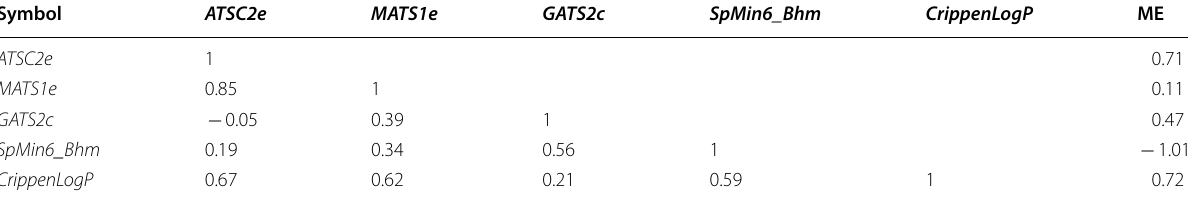
Table 3 Pearson’s correlation and mean effect values of the descriptors for model one Symbol ATSC2e